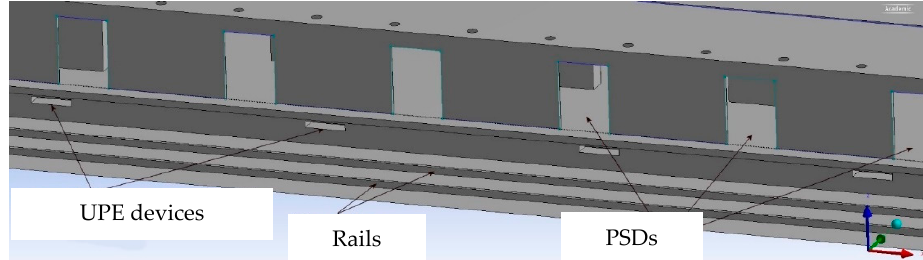
Figure 7. UPE system in the subway